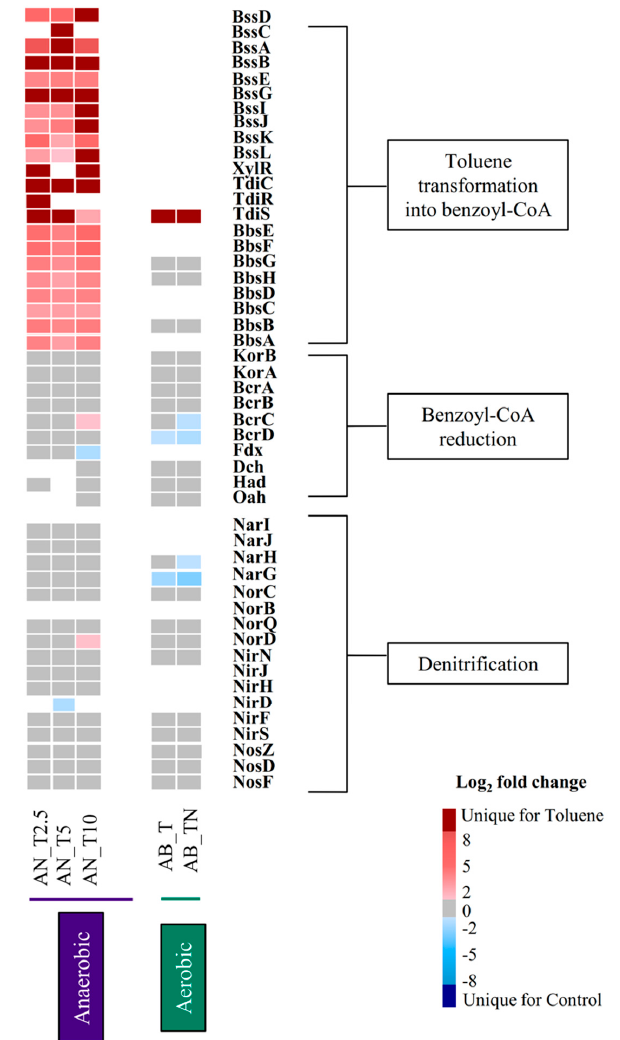
Figure 4. Heatmap visualization of protein regulation required for toluene and benzoate degradation pathways in anaerobic denitrifying and aerobic cultures of Magnetospirillum sp. 15-1. Up-regulated proteins are represented by n ≥ 1 and are coloured in shades of red. Down-regulated proteins are represented by n ≤ − 1 and are coloured in shades of blue. AN_T represents cultures growing anaerobically with toluene and either 2.5 mM (AN_T2.5), 5 mM (AN_T5), or 10 mM (AN_T10) of KNO 3 . AB_T represents cultures growing aerobically with benzoate and supplied additionally with either toluene alone (AB_T) or toluene and 5 mM of KNO 3 (AB_TN). BssD, benzylsuccinate activating enzyme; BssABC, benzylsuccinate synthase; BssE, putative chaperone; BssG-J and BssL, unknown function; BssK, mRNA binding protein; XylR, σ 54 -dependent regulator, TdiC, regulator of TdiR activity; TdiR, toluene degradation regulator; TdiS, toluene degradation inducing sensor; BbsEF, (3-methyl)benzylsuccinate CoA transferase; BbsG, (3-methyl)benzylsuccinyl-CoA dehydrogenase; BbsH, (3-methyl)phenylitaconyl-CoA hydratase; BbsCD, 2-[hydroxyphenyl(methyl)]-succinyl-CoA dehydrogenase; BbsAB, (3-methyl)benzoylsuccinyl-CoA thiolase; BclA, benzoate-CoA ligase; KorBA, 2-oxoglutarate oxidoreductase; BcrABCD, benzoyl-CoA reductase; Fdx, 4Fe-4S ferredoxin; Dch, dienoyl-CoA hydratase; Had, 6-hydroxycyclohex-1-ene-1-carboxyl-CoA dehydrogenase; Oah, 6-oxocyclohex-1-enecarboxyl-CoA hydrolase; NarGHI, nitrate reductase; NarJ protein assembly; NorCB, nitric oxide reductase; NorQ and NorD, unknown function; NirN, haem d1 insertion protein; NirJHLD, unknown functions; NirF, membrane attached lipoprotein; NirS, nitrite reductase; NosZ, nitrous oxide reductase; NosD, putative Cu insertase; NosF, ATP-hydrolyzing of ABC